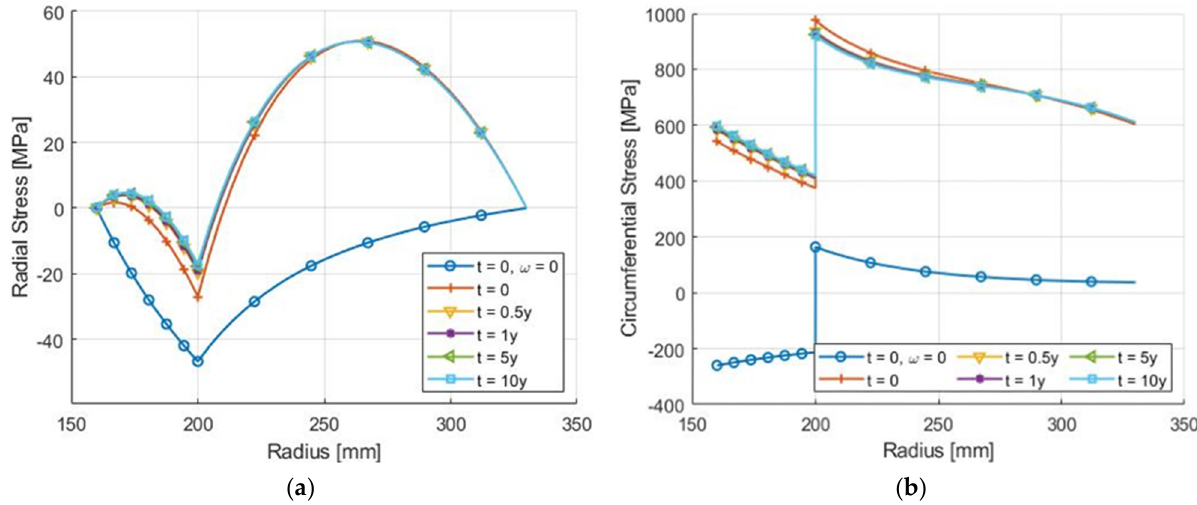
Figure 3. Radial ( a ) and circumferential ( b ) stress predictions for a flywheel rotor constructed of an aluminum hub and CFRP rim, after assembly (zero velocity), at startup, and at various times up to 10 years of continuous operation at the limit velocity of 24,250 rpm.